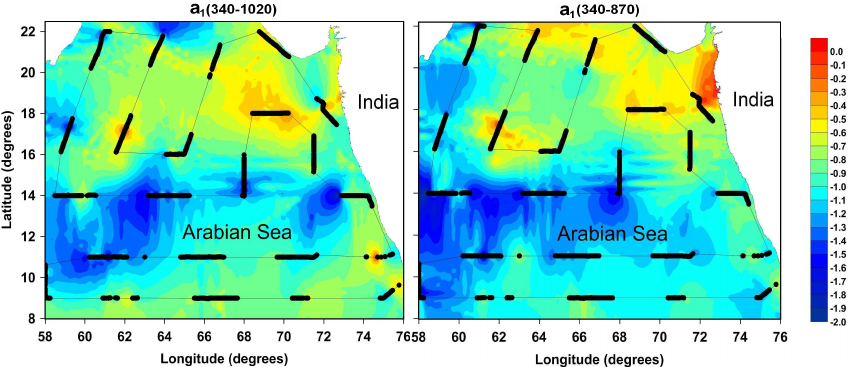
Figure 9. Fig. 9. Same as Figure 8 but for a 1 values regarding the whole set of measurements over the AS region computed in the 340–1020-nm band (left) and the 340–870-nm band